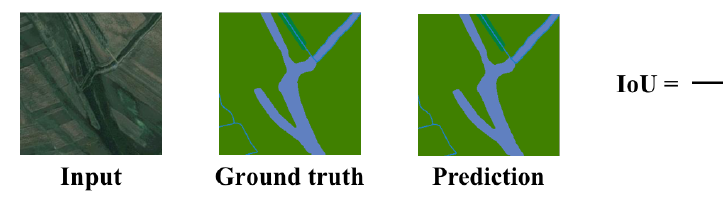
Figure 7. Calculation process of IoU